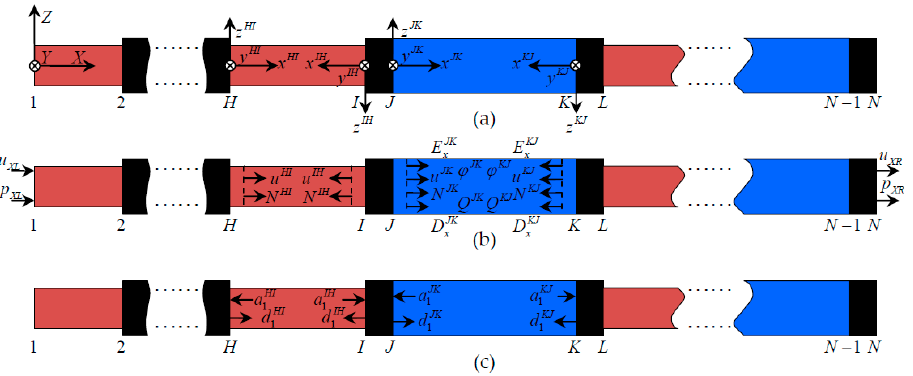
Figure 2. The description of the unit cell: ( a ) the global and local coordinates; ( b ) the convention of generalized displacements and forces; and ( c ) the convention of wave amplitudes.